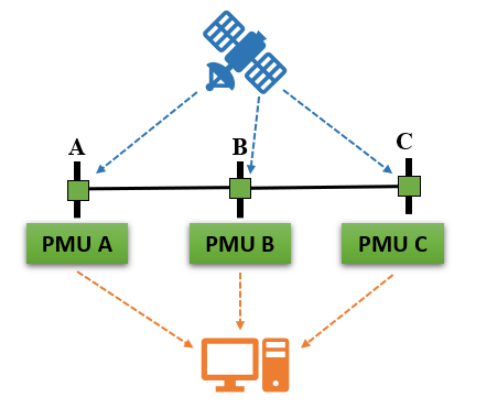
Figure 2. Simplified centralized synchrophasor